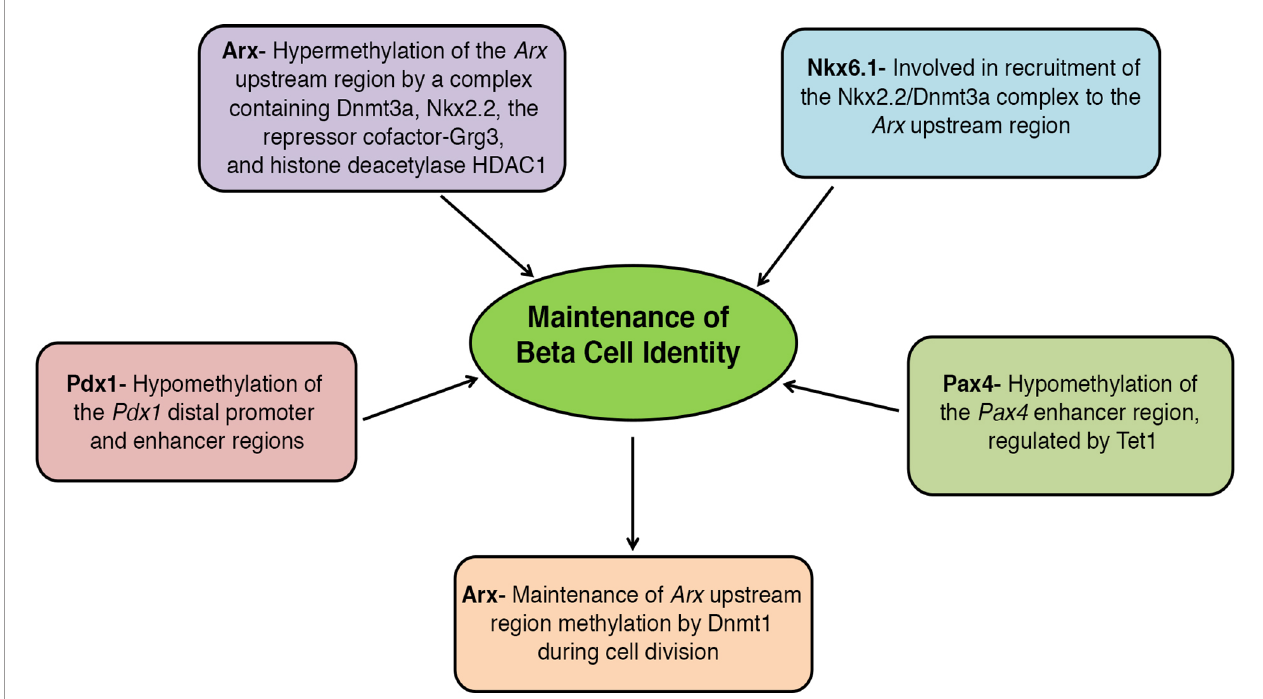
FIGURE 3 | Key players involved in DNA methylation dependent regulation of beta cell identity: Hypermethylation of the alpha cell lineage regulator gene, Arx , represses its expression in beta cells, while hypomethylation of Pdx1 and Pax4 in beta cells is essential to maintain their expression. The speci fi city of DNA methylation patterning is ensured by the interaction of DNA methyltransferase Dnmt3a with transcription factors Nkx2.2 and Nkx6.1, allowing recruitment to speci fi c sites. Once established, the beta cell speci fi c DNA methylation patterns are maintained by the maintenance methyltransferase